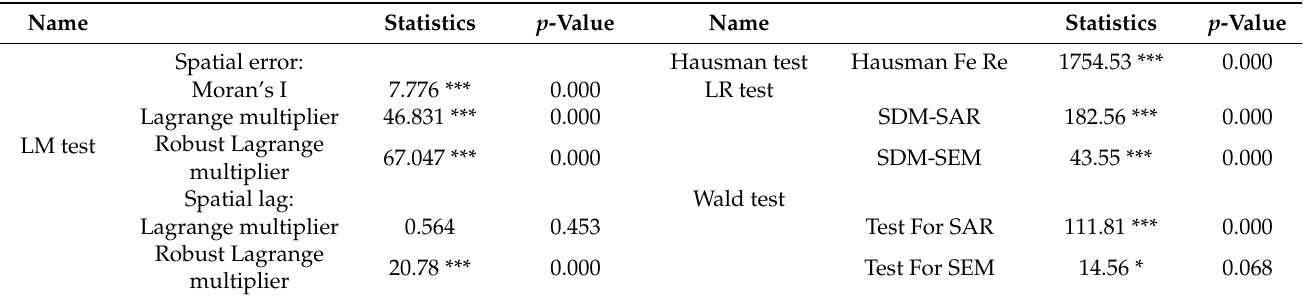
Table 8. Spatial model testing